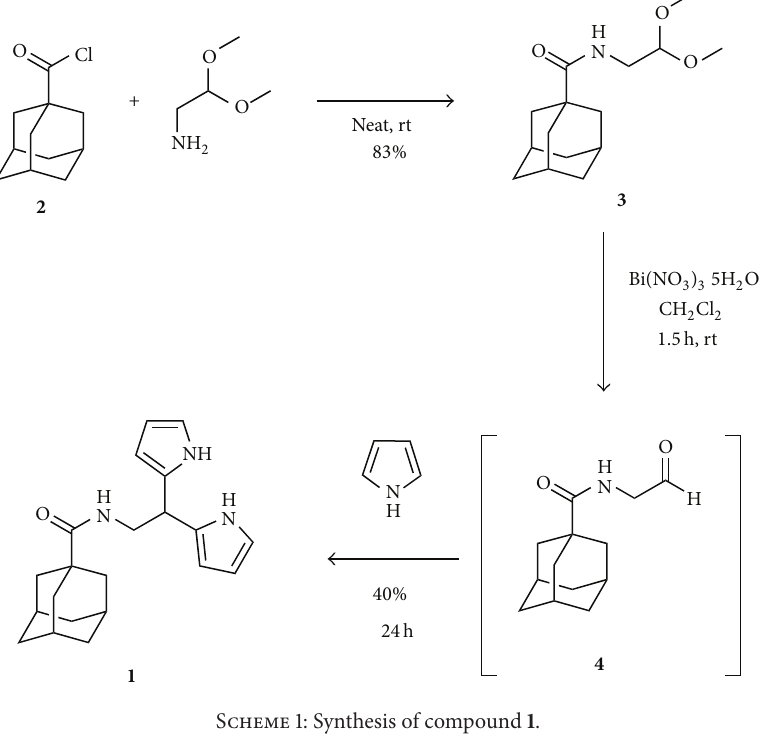
Scheme 1: Synthesis of compound 1 .